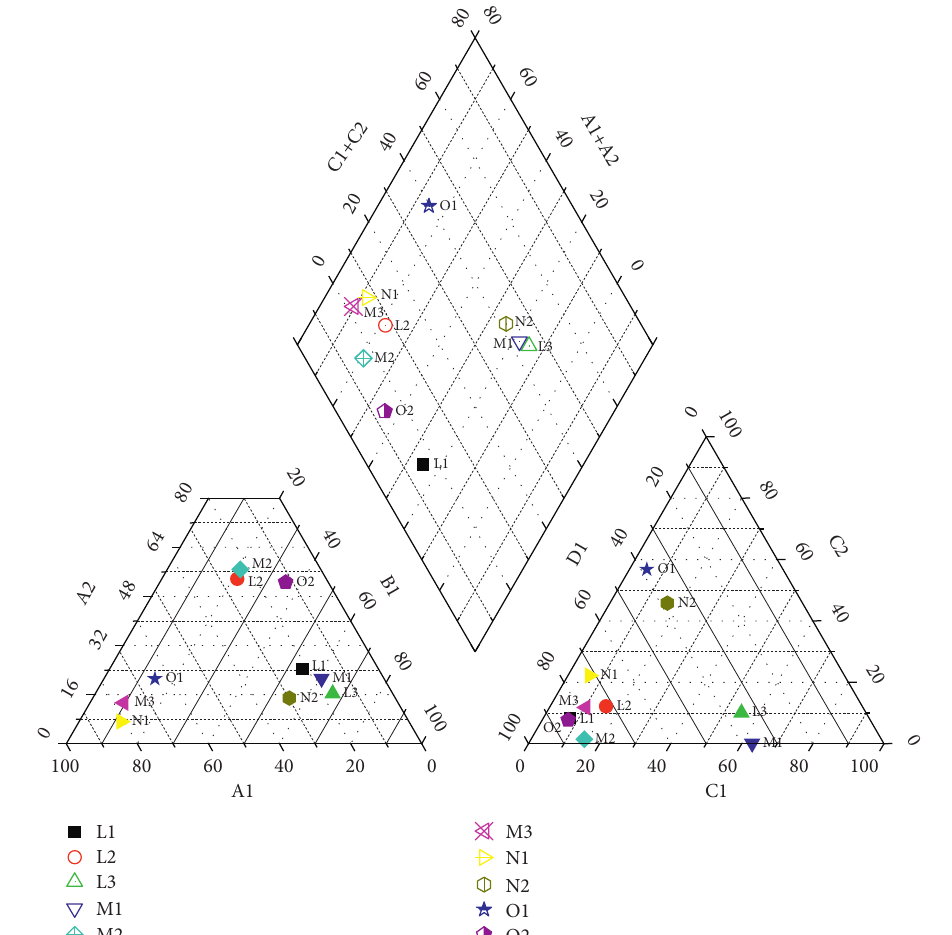
Figure 4: Conversion